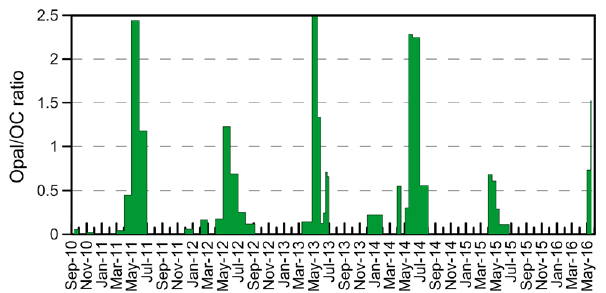
Figure 6. Ratio between the opal and OC contents within sediment trap samples from September 2010 to May